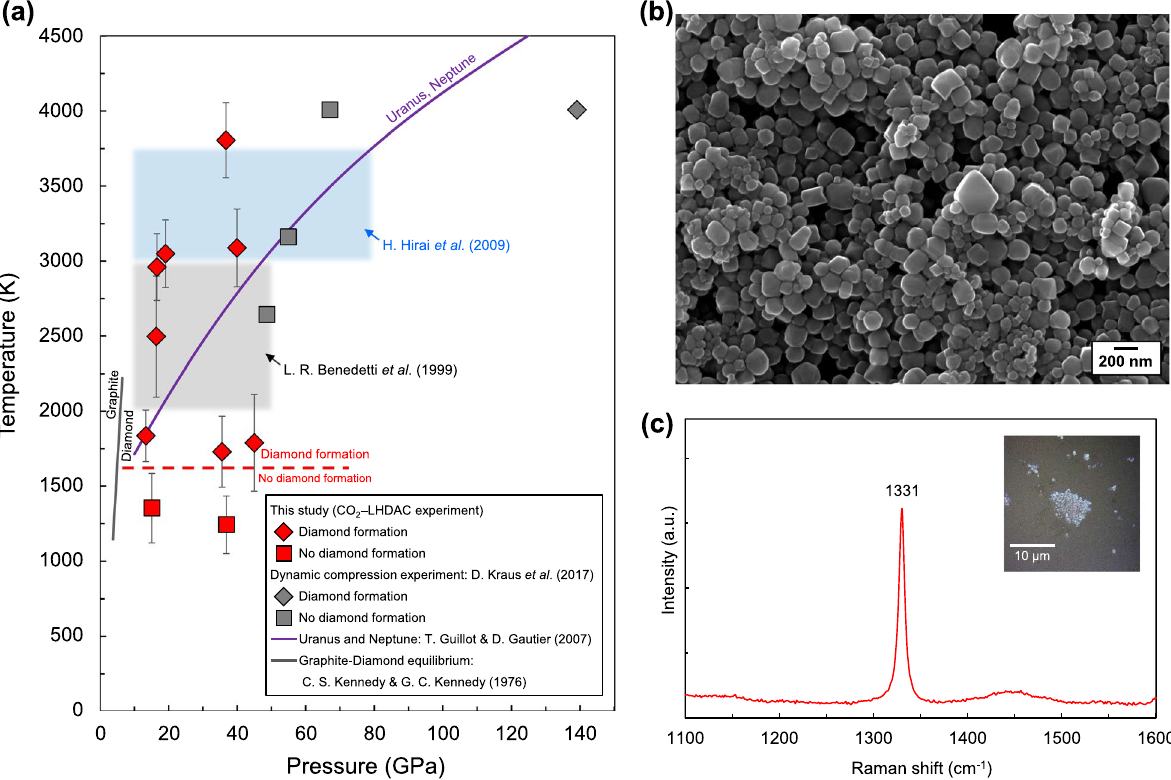
Fig. 6 Diamond formation by melting and the molecular dissociation of methane at extremely high temperatures and pressures. a Region of diamond formation. b SEM image of diamond particles recovered at ambient temperature and pressure, including octahedral particles. c Raman spectra of the recovered sample on a glass slide with the characteristic peak for diamond at 1331 cm − 1 . This figure is modified from Kadobayashi et al.